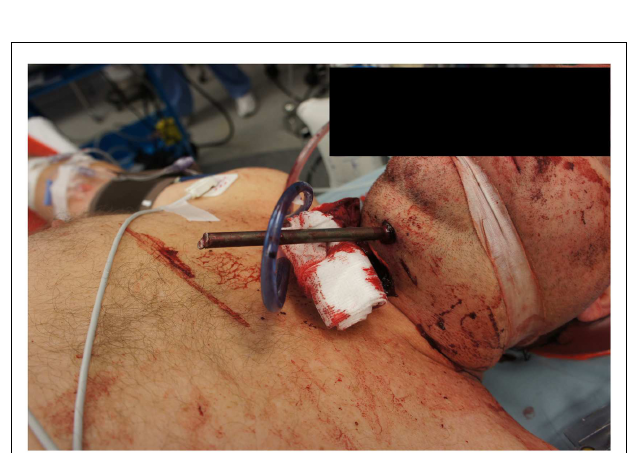
was severely impaired by metallic artifact, as no dual-energy CT (DECT) scanner was available. Using the images obtained, the course of the foreign object was determined to proceed through the left submandibular region, oral cavity, retropharyngeal soft tissues, left petrous apex, left carotid canal, left temporal horn of the left lateral ventricle, posterior aspect of the left frontal lobe, left temporal lobe, and its partial exit through and out of the left temporoparietal region ( Figures 1 – 4 ). Evidence of bone and pos- sibly metallic fragments within the left temporal lobe along the harpoon’s tract was also observed. Intraventricular hemorrhage of the left lateral ventricle was present. CT angiography showed non-opacification of the cervical and petrous portions of the left internal carotid artery (ICA), likely related to the projectile’s path directly transecting the left carotid canal,but adequate distal filling due to collateral supply was also visualized.A retrograde